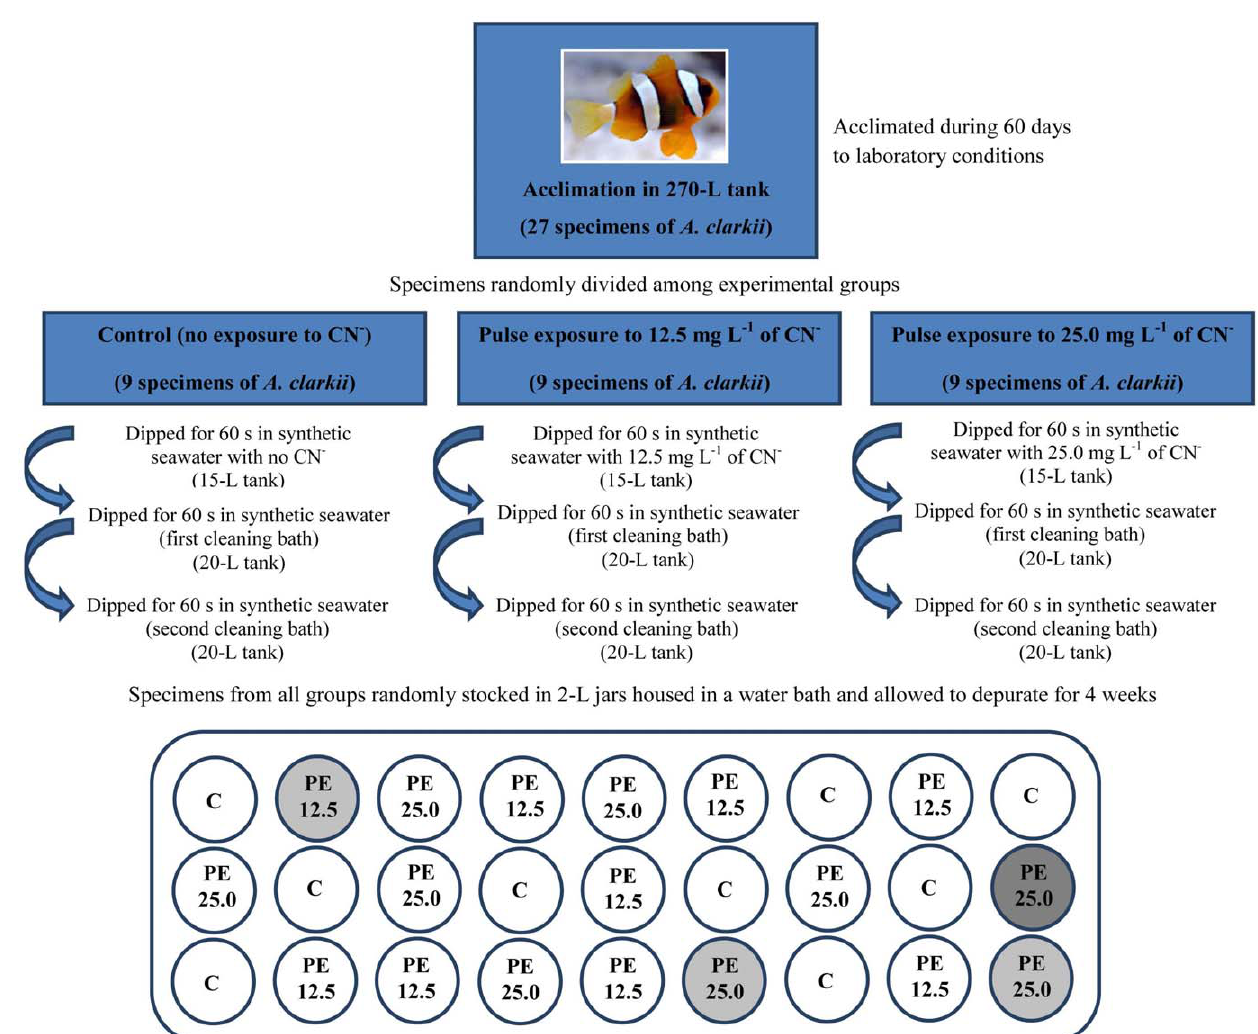
Figure 1. Schematic representation of experimental procedures for cyanide (CN 2 ) pulse exposure and depuration of Amphiprion clarkii . C – control specimens not exposed to CN 2 ; PE 12.5 – Specimens pulse exposed during 60 s to 12.5 mg L 2 1 of CN 2 ; PE 25.0 - Specimens pulse exposed during 60 s to 25.0 mg L 2 1 of CN 2 ; Circles with a white background represent specimens surviving until the end of the depuration period, while light and dark grey backgrounds represent specimens dying at least 30 min after the pulse exposure and during the depuration period, respectively.